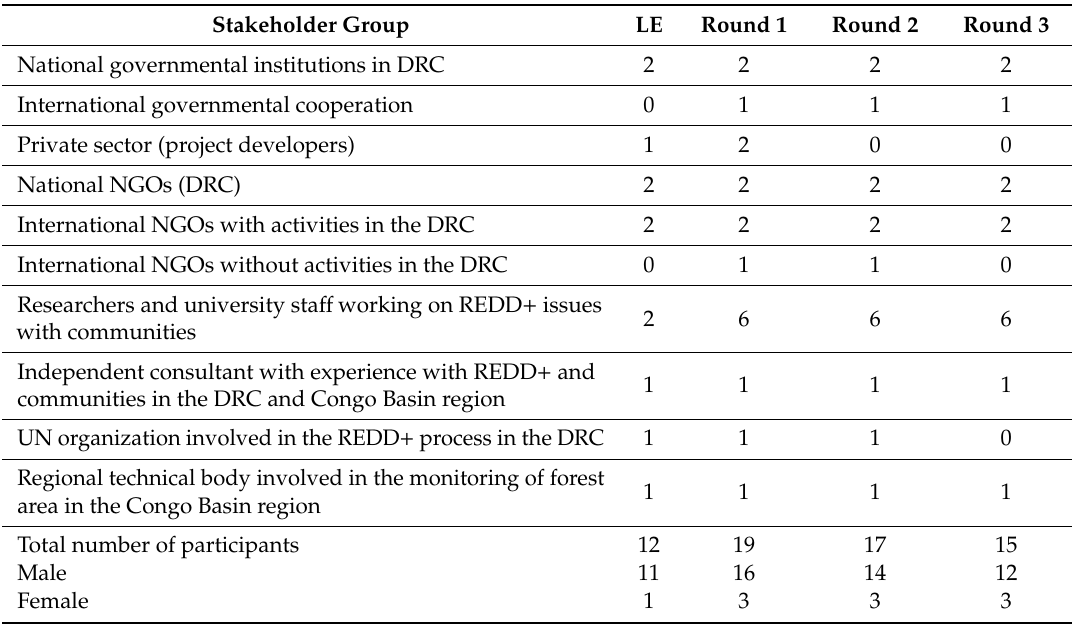
Table 1. Number of participants in the three rounds of the Delphi study by stakeholder group. Local expertise (LE) refers to the number of experts in each group that had experience on the ground regarding REDD + project implementation and community involvement in the DRC or elsewhere. Stakeholder Group LE Round 1 Round 2 Round